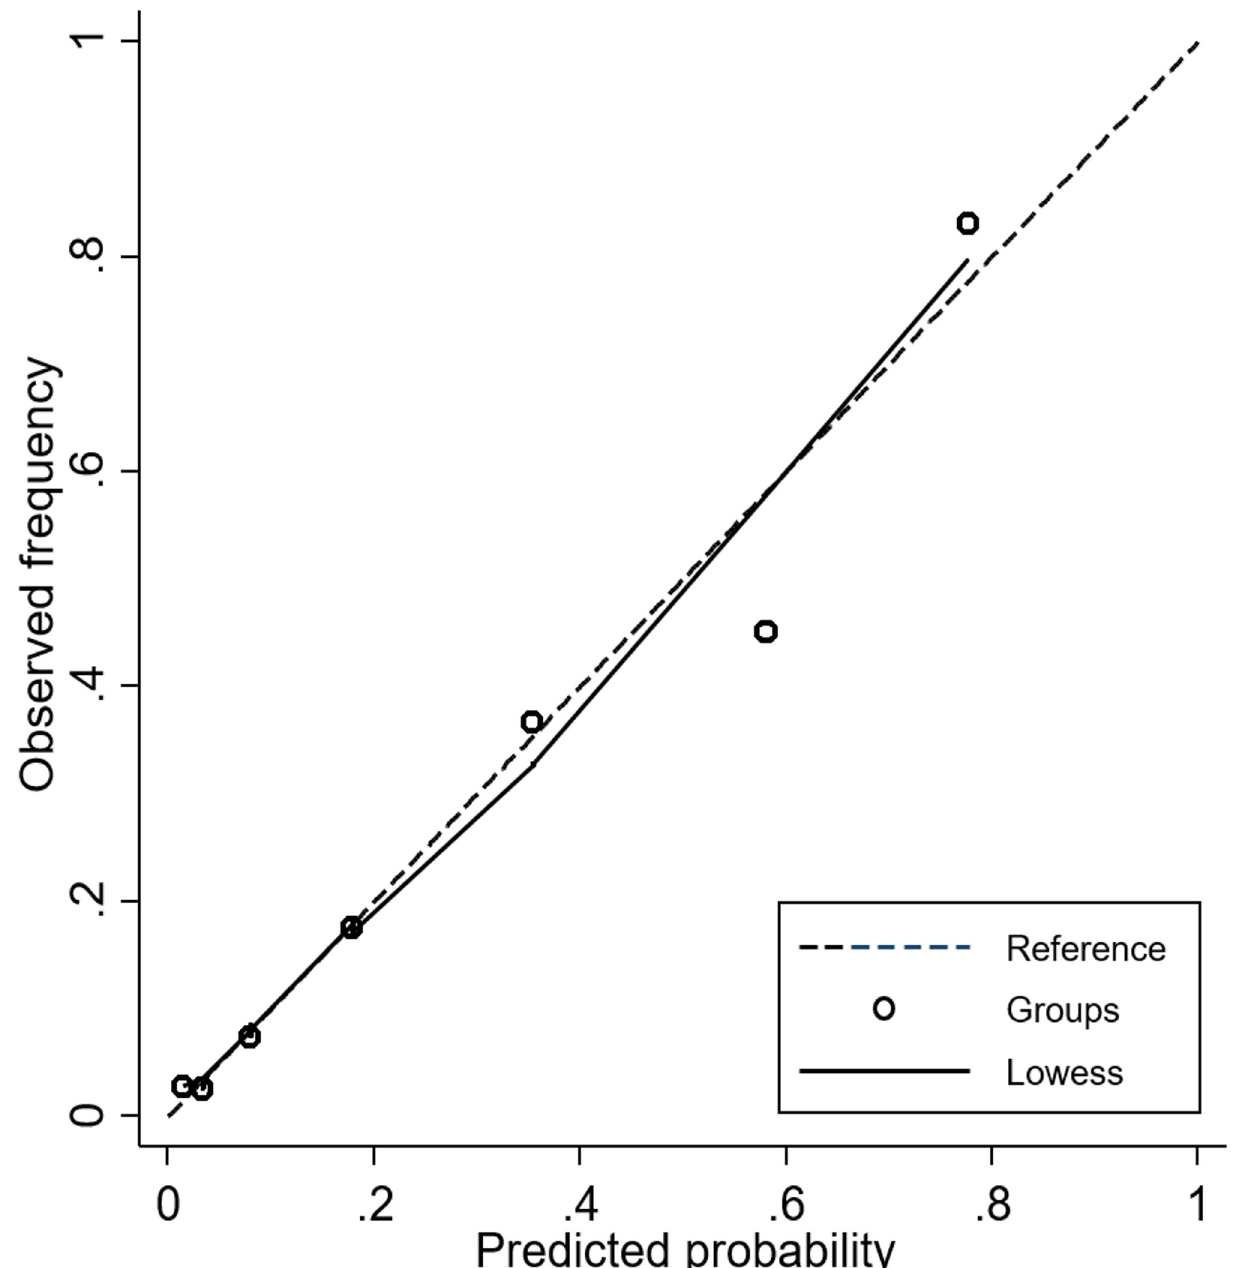
Fig 2. Calibration plot of Patient Acuity Rating for predicting the probability of the composite outcome.